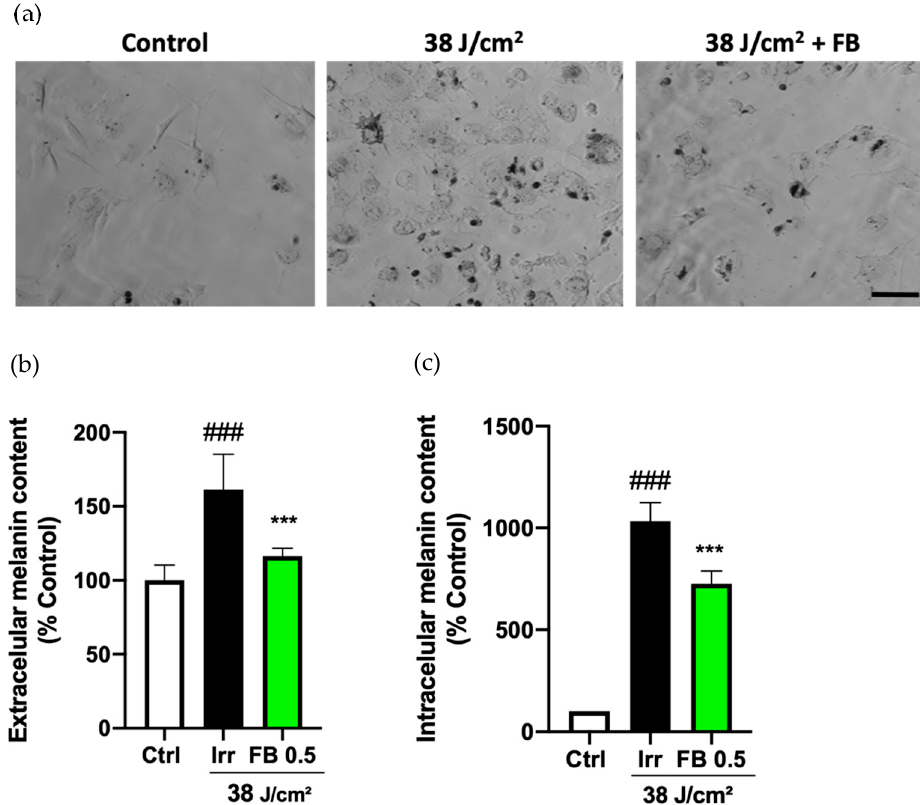
Figure 5. Melanin content in melanocytes exposed to artificial blue light with and without FB pre-treatment (0.5 mg/mL). Microphotographs show how unirradiated (control), irradiated and treated melanocytes produce different amounts of melanin dark granules ( a ). Cells were incubated in phenol red-free DMEM 1% FBS and FB for 24 h, irradiated (38 J/cm 2 ), fresh medium replaced, melanin pigments collected, solubilized, and quantified ( b ), and ( c ) 3 h later by absorbance measurements. Data were normalized by mg protein and expressed as % of control cells (n ≥ 4). Data are shown as mean ± SEM. ### p < 0.001 vs. control; *** p < 0.001 vs. irradiated. Scale bar: 50 µm.